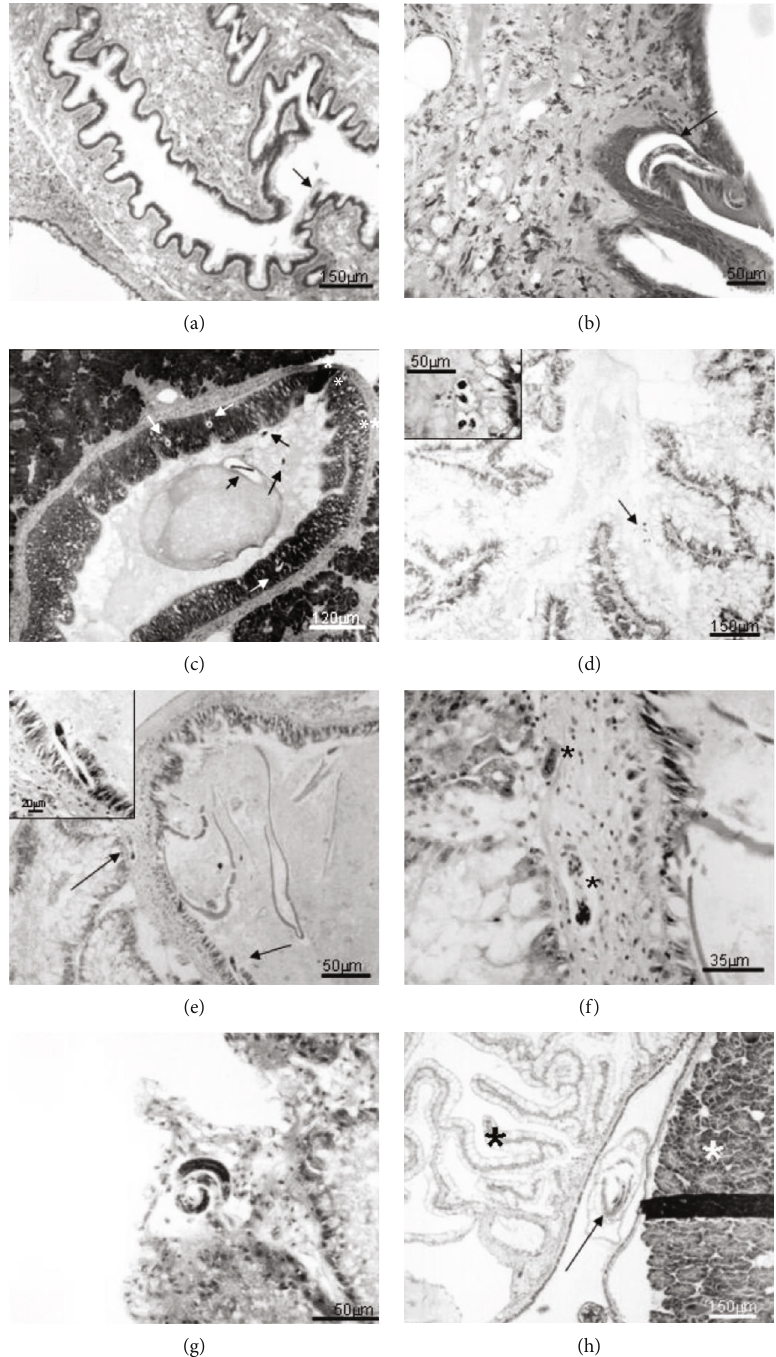
Figure 1: Histological sections of Biomphalaria glabrata infected with 1000 L1 of Angiostrongylus vasorum . Hematoxylin and eosin staining. (a) Overview of a portion of the digestive tube with a nematode (black arrow) near the mucosa after thirty minutes of the beginning of infection; (b) larva (L1) penetrating in the epithelium of the dorsalis pedis mass of the gastropod after thirty minutes of the beginning of infection; (c) overview of the stomach region with several larvae in the lumen (black arrows), in the epithelium (white arrows), and next to the basal membrane (white asterisks) after one hour of the beginning of the infection; (d) larvae inside of the digestive gland after two hours from the beginning of infection; (e) larva (L1) penetrating the mucosa of the midgut (see expanded detail). In larger arrow, larvae located in the subconjunctival epithelial layer, two hours after the beginning of infection; (f) detail of previous photo showing a discrete local cellular reaction; (g) larva located in the hemocoel of the digestive gland showing a discrete local cellular reaction after three hours of the beginning of infection; (h) larvae inside the circulatory system (arrow) between the albumen gland (white asterisk) and the kidney (black asterisk) after four hours of the beginning of the infection. Magni fi cations: (a, d) 150 μ m; (b, e) 50 μ m; (c) 120 μ m; (f): 35 μ m; (g) 60 μ m; (h) 160 μ